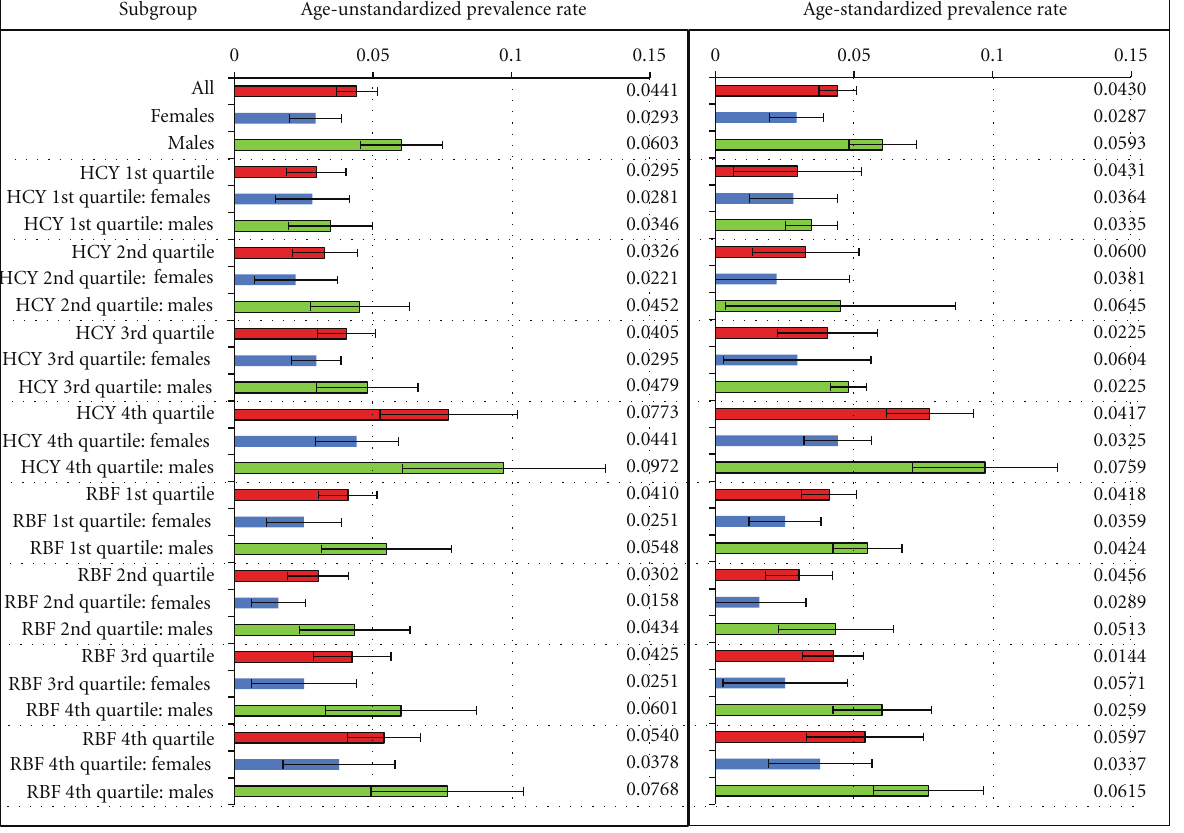
Figure 1: Prevalence of diagnosed, self-reported sleep apnea in the NHANES 2005-2006 dataset based on gender and quartiles of plasma homocysteine and RBC folate. The plot on the left is not standardized for age while the plot on the right shows age-standardized rates. Prevalence rates are shown as horizontal bars, and the estimates are indicated by the value at the right side of the plots. Error bars indicate the 95% confidence interval for the prevalence rates. Prevalence rates are shown for all subjects (red bars), females only (blue bars) and males only (green bars). Range of values for plasma homocysteine and RBC folate represented by their respective quartiles is described in text. HCY: plasma homocysteine; RBF: RBC